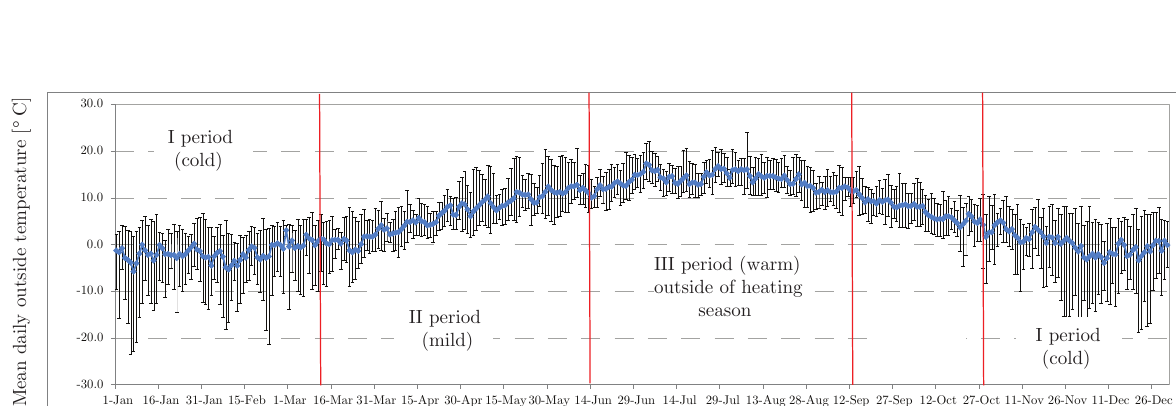
Figure 4: Average mean daily temperature for years 2006-2014